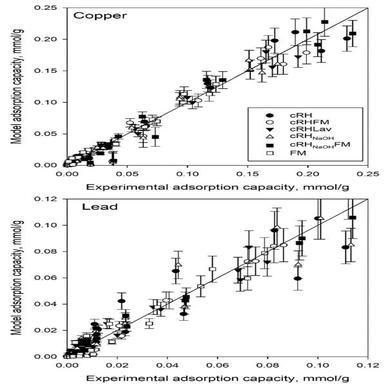
Parity plots on adsorption capacity for Cu2+ and Pb2+ ions adsorption data.